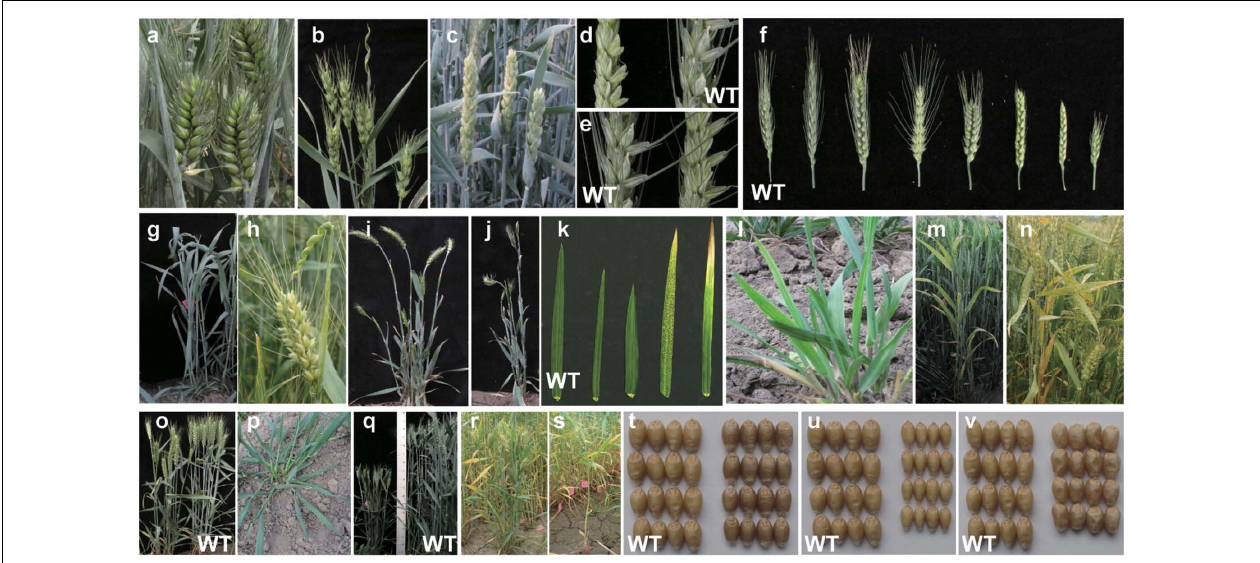
FIGURE 1 | Phenotypic mutations in the mutagenized wheat population. (a–f) Represent spike morphology mutations observed in mutagenized wheat. (a) Compact spike; (b) degenerated spike; (c) awnless spike; (d) male sterile spike without awn; (e) male sterile spike with awn; (f) totality of spike mutation phenotypes. (g–n) Represent mutation in leaf morphology. (g,h) Curly flag leaf; (i,j) degenerated leaf; (k) leaf size and chlorophyll content variation; (l) yellow-striped leaf; (m) chlorotic leaf; (n) necrotic leaf. (o–s) Represent plant architecture mutations observed. (o) Waxless plant; (p) prostrate growth habit; (q) dwarfing plant; (r) increased tiller numbers; (s) single tiller. (t–v) Represent mutations in seed morphology. (t) Red grain; (u) small grain; (v) wrinkle grain.